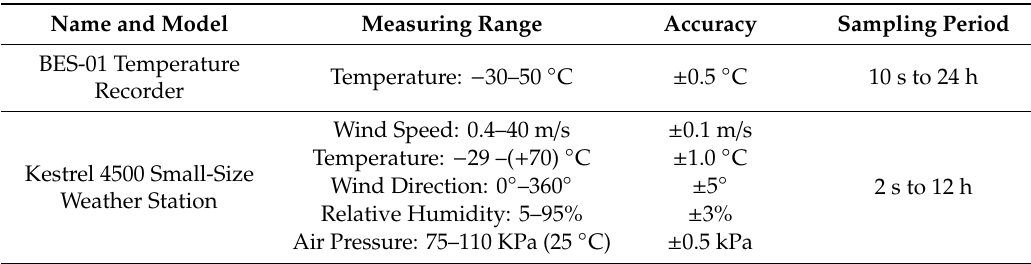
Table 3. Instrument technical